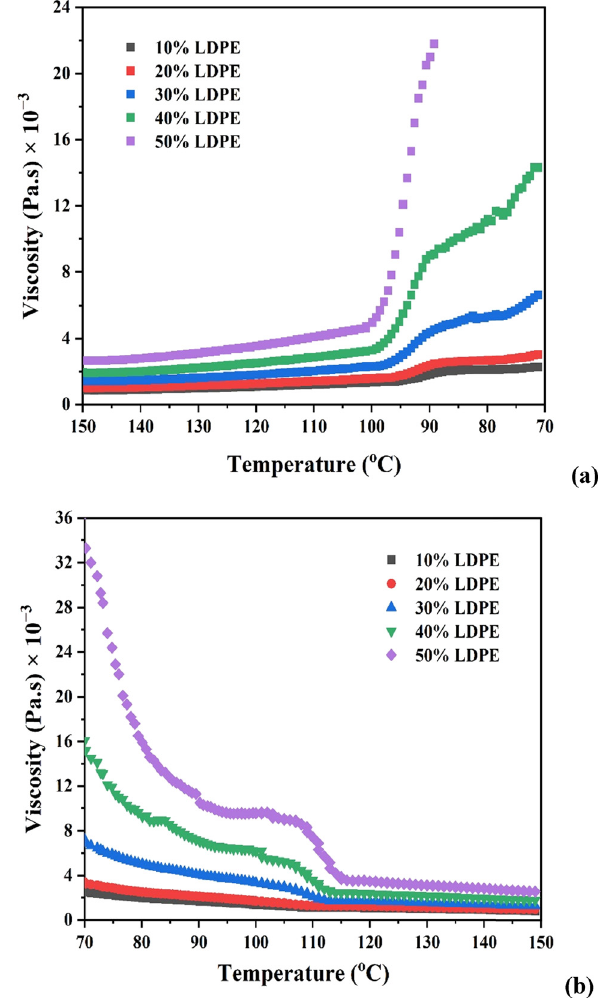
Figure 2: Variation of viscosity with the temperature at di ff erent LDPE concentrations: ( a ) cooling cycle and ( b ) heating